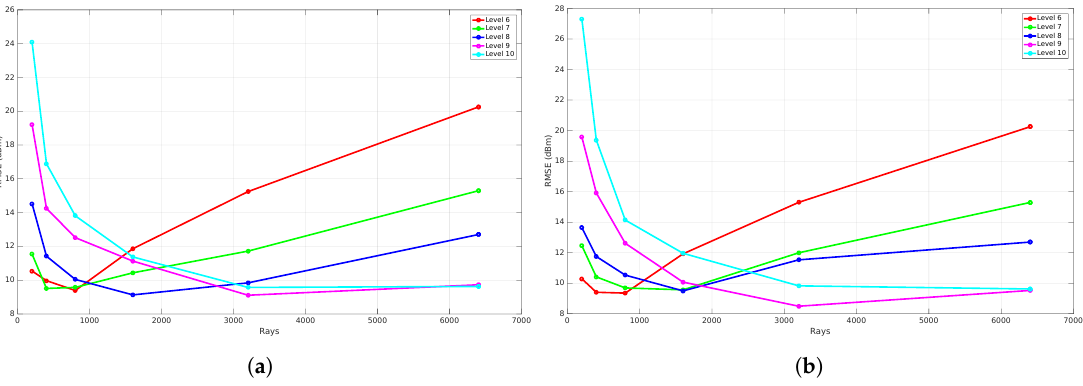
Figure 19. RMSE validation of the first office environment where eight neighbors are included. ( a ) no phase shifts are included; ( b ) phase shifts are